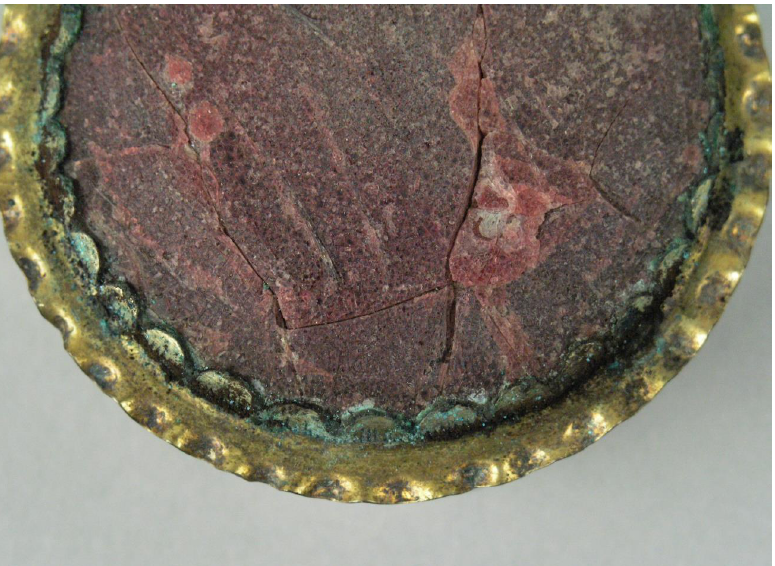
Figure 7. ⑥ on a gilded silver box with ruby glass, Green Vault Dresden IV169 (Photo: R. Richter).